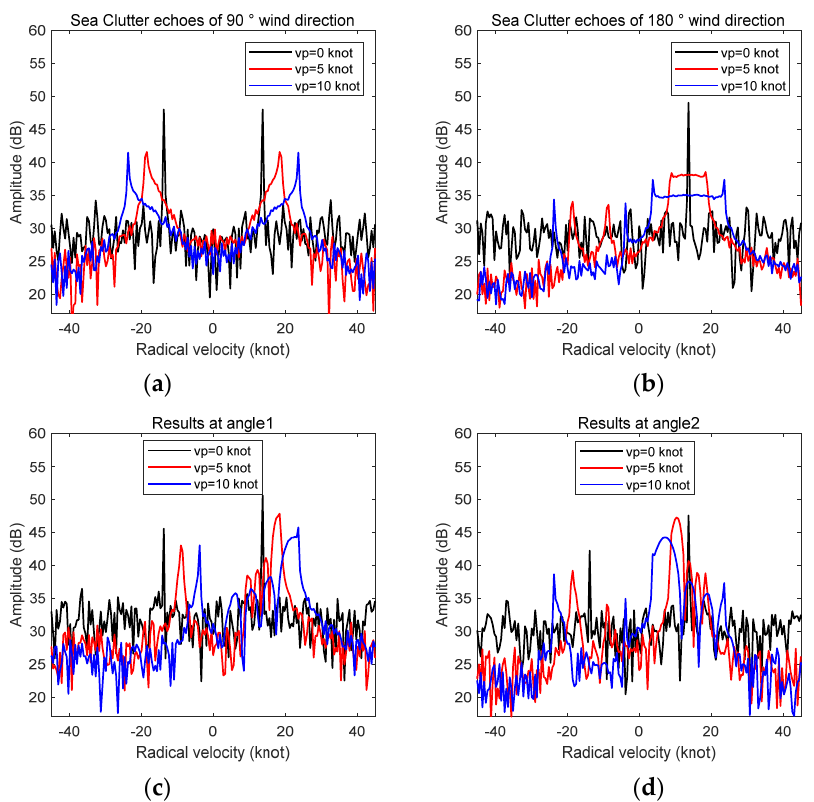
Figure 5. Simulation results of sea clutter spectrum in case of uniform linear motion: ( a ) channel results when the wind direction is 90°, ( b ) channel result when the wind direction is 180°, ( c ) beam results at angle 1 when the wind direction is 180°, ( d ) beam results at angle 2 when the wind direction is 180°.